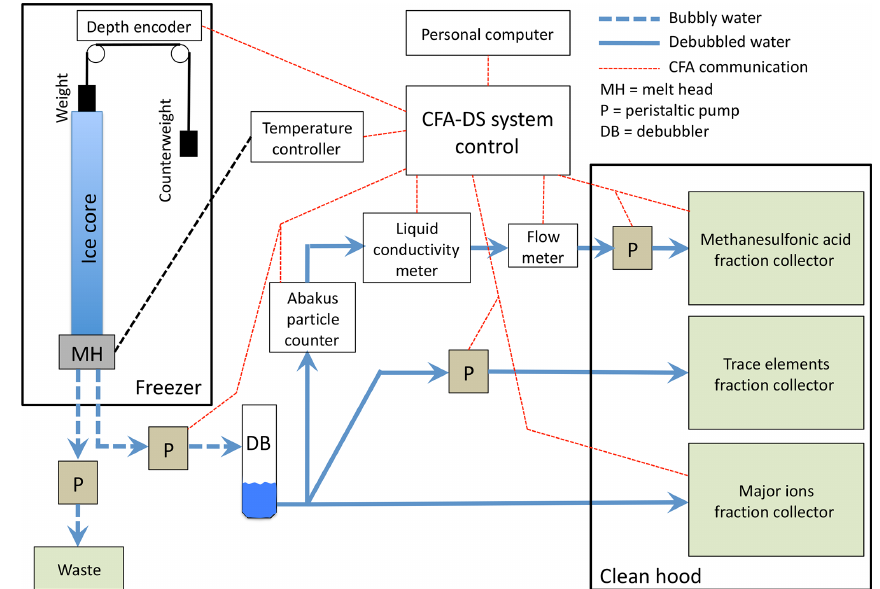
Figure 1. A schematic representation of the Dartmouth ice core melter